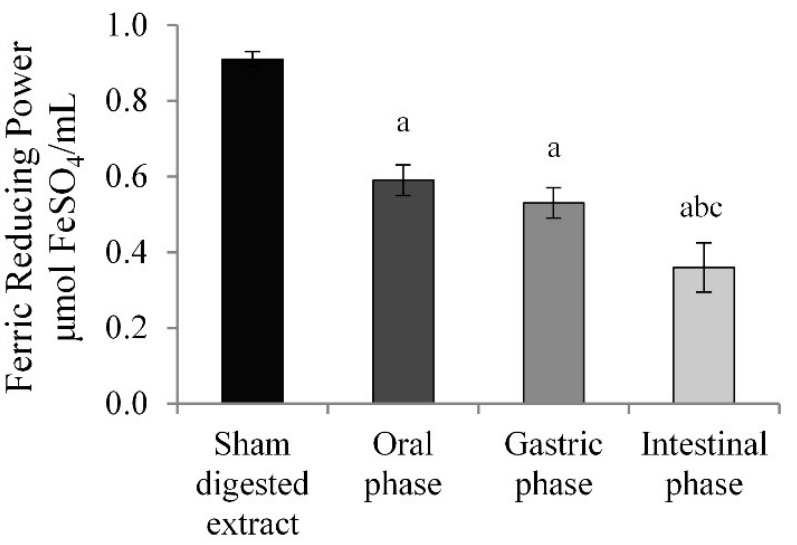
Figure 2. FRAP assay. Results are reported as µ mol FeSO 4 /mL of sham-digested or digested extract